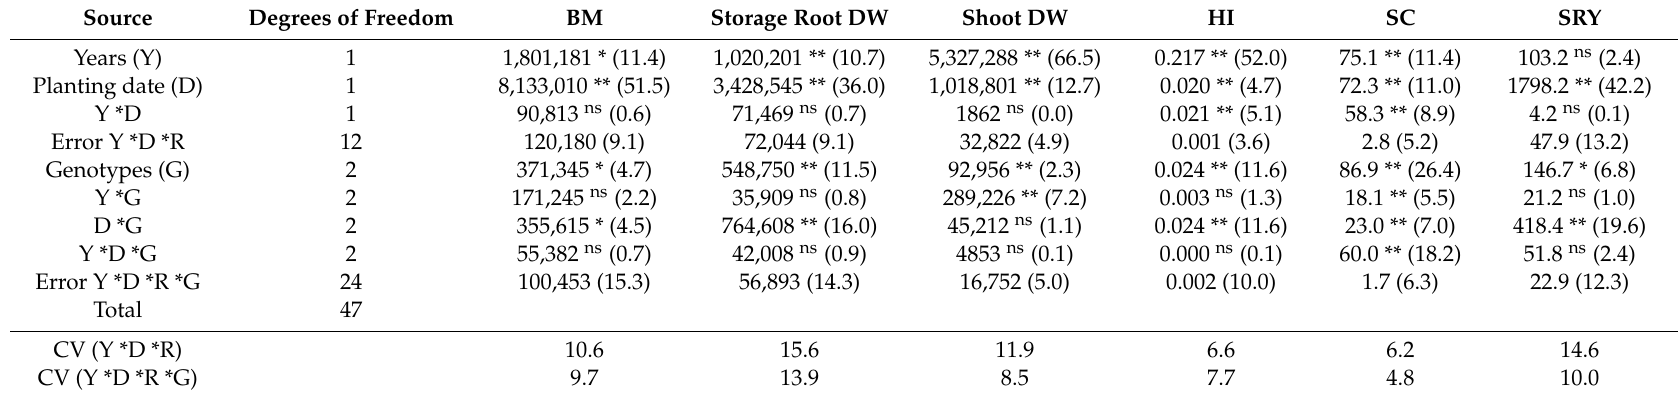
ns , *, ** = non-significant and significant at p ≤ 0.05 and p ≤ 0.01 probability levels, respectively, Values in parentheses are percentages of sum squares. CV; coe ffi cient of variation